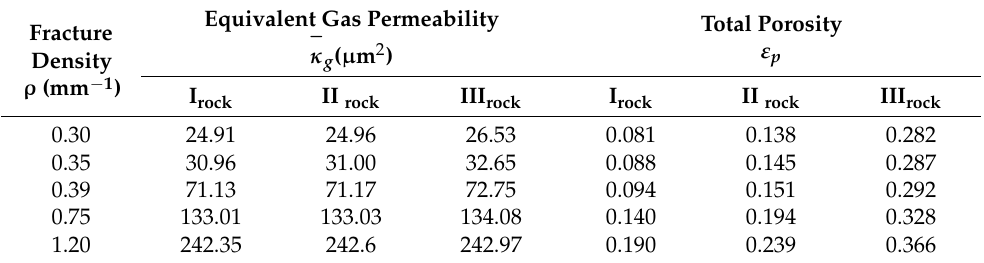
Table 6. Equivalent permeability and total porosity of rocks with three different matrix properties.